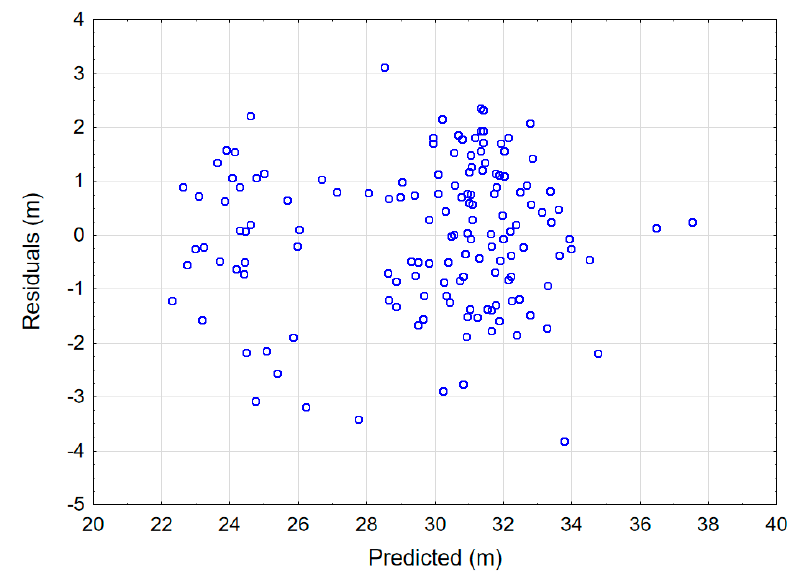
Figure 8. Residual versus predicted values of the developed GAM site index model for oak.